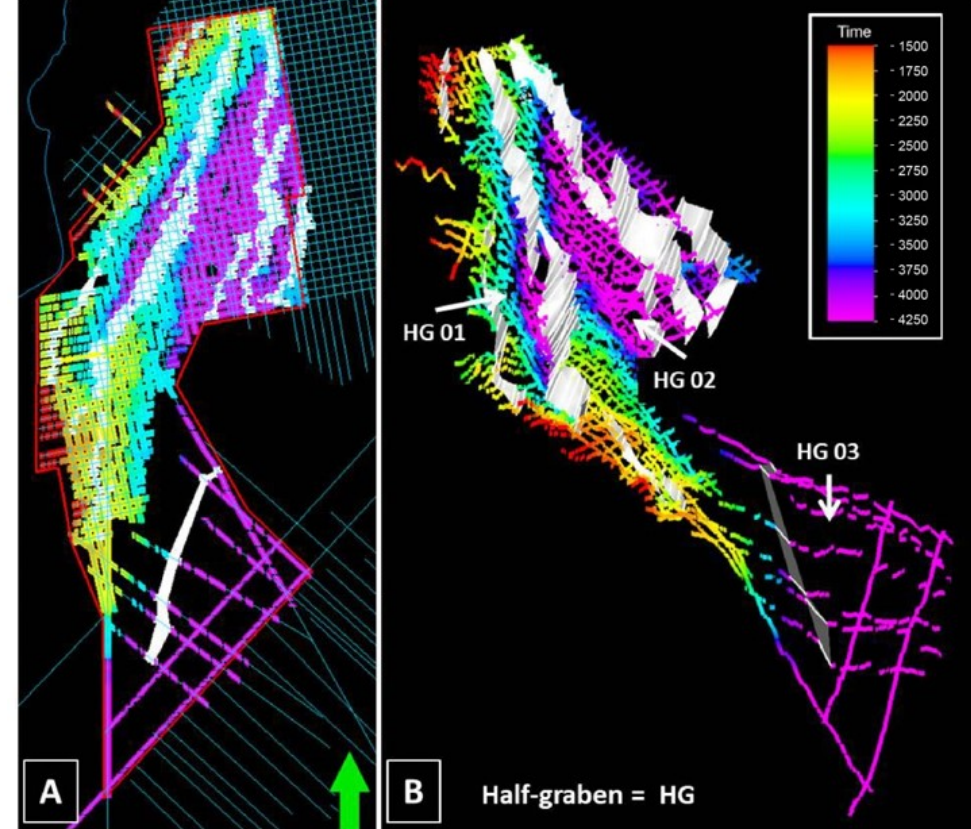
Figure 4. Map of a reference surface (Cabi ú nas Top) and border faults (in white) in the study area. ( A ) Half-grabens mapped at seismic depth. ( B ) Three-dimensional view of the study area, showing the structure of the mapped